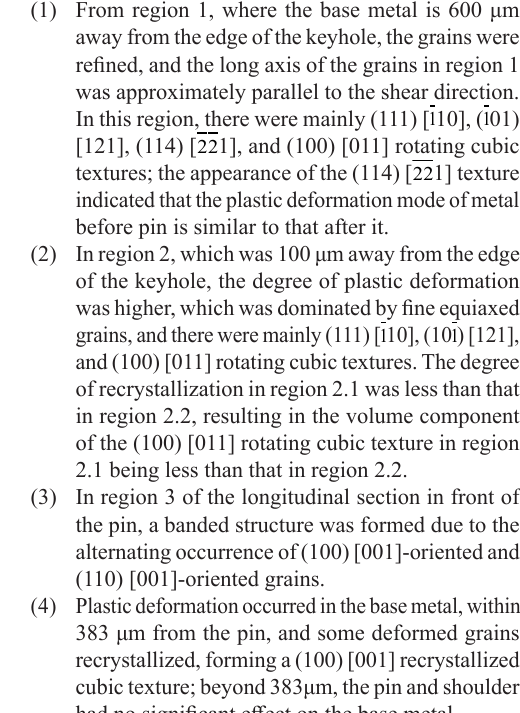
Figure 13. Schematic diagram of microstructure evolution in front of pin.